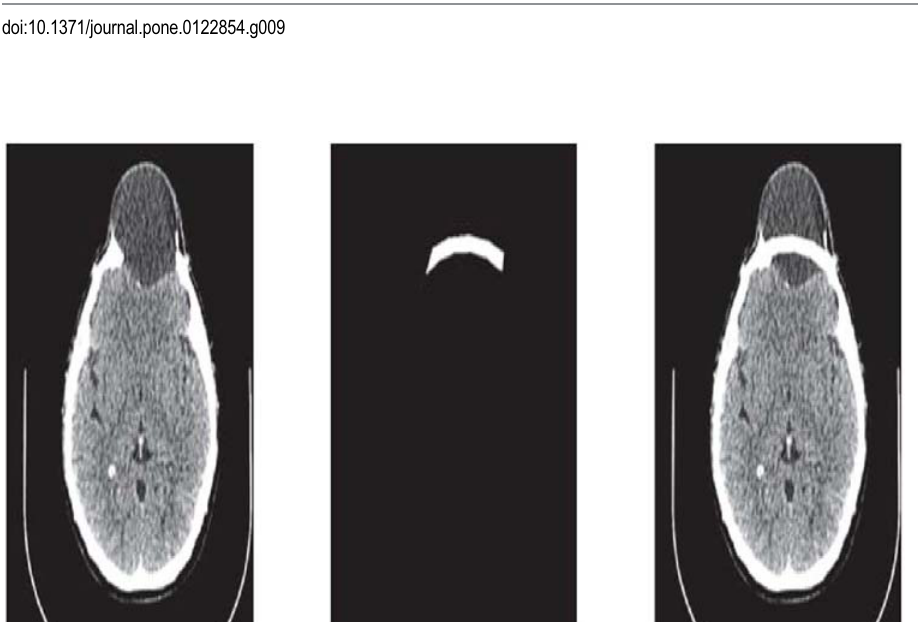
Fig 10. Missing data in Dicom format of slice